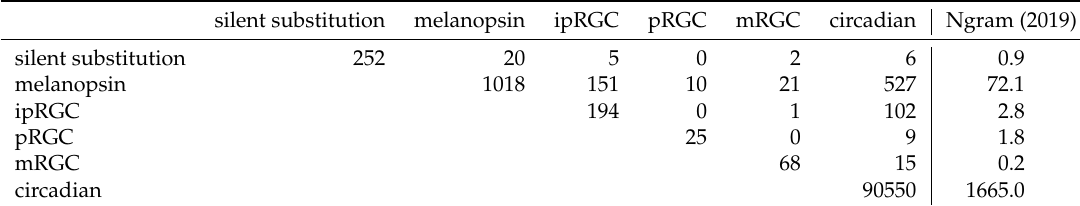
Table 1. Number of articles found on PubMed on the 14th of May, 2020 with the keywords and their combinations. The diagonal shows the result for a single term. The last column gives the 10 − 9 occurrence of the word within the books digitalized by Google (Ngram) as of